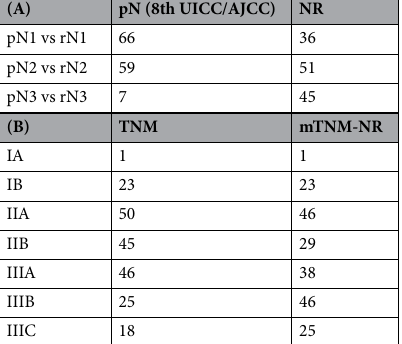
Table 3. Migration between numeric-based versus lymph node ratio-based staging systems for remnant gastric cancer. (A) pN (8th UICC/AJCC) vs. NR staging systems, (B) TNM (8th UICC/ AJCC) vs. mTNM-NR